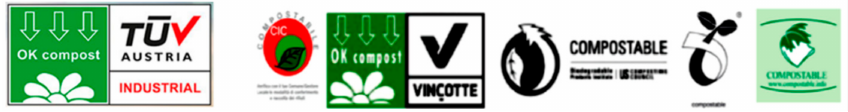
Figure 1. Examples of labels for certification of compostable